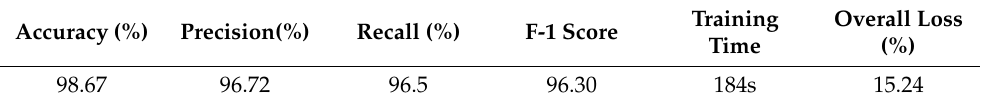
Table 7. Performance metric of the proposed model